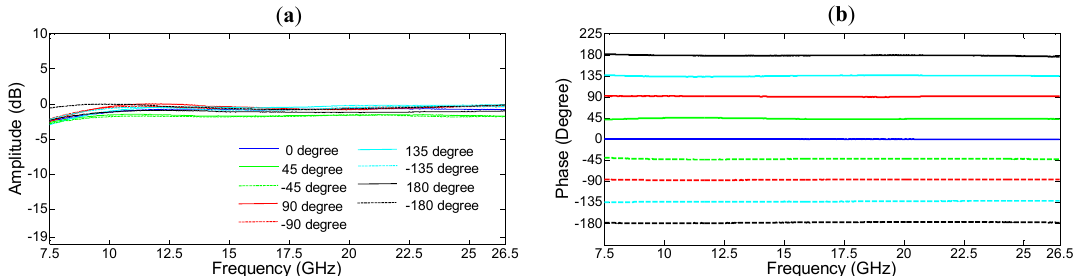
Figure 7. The measured ( a ) amplitude and ( b ) phase response of the microwave photonic phase shifter based on LCOS technology.